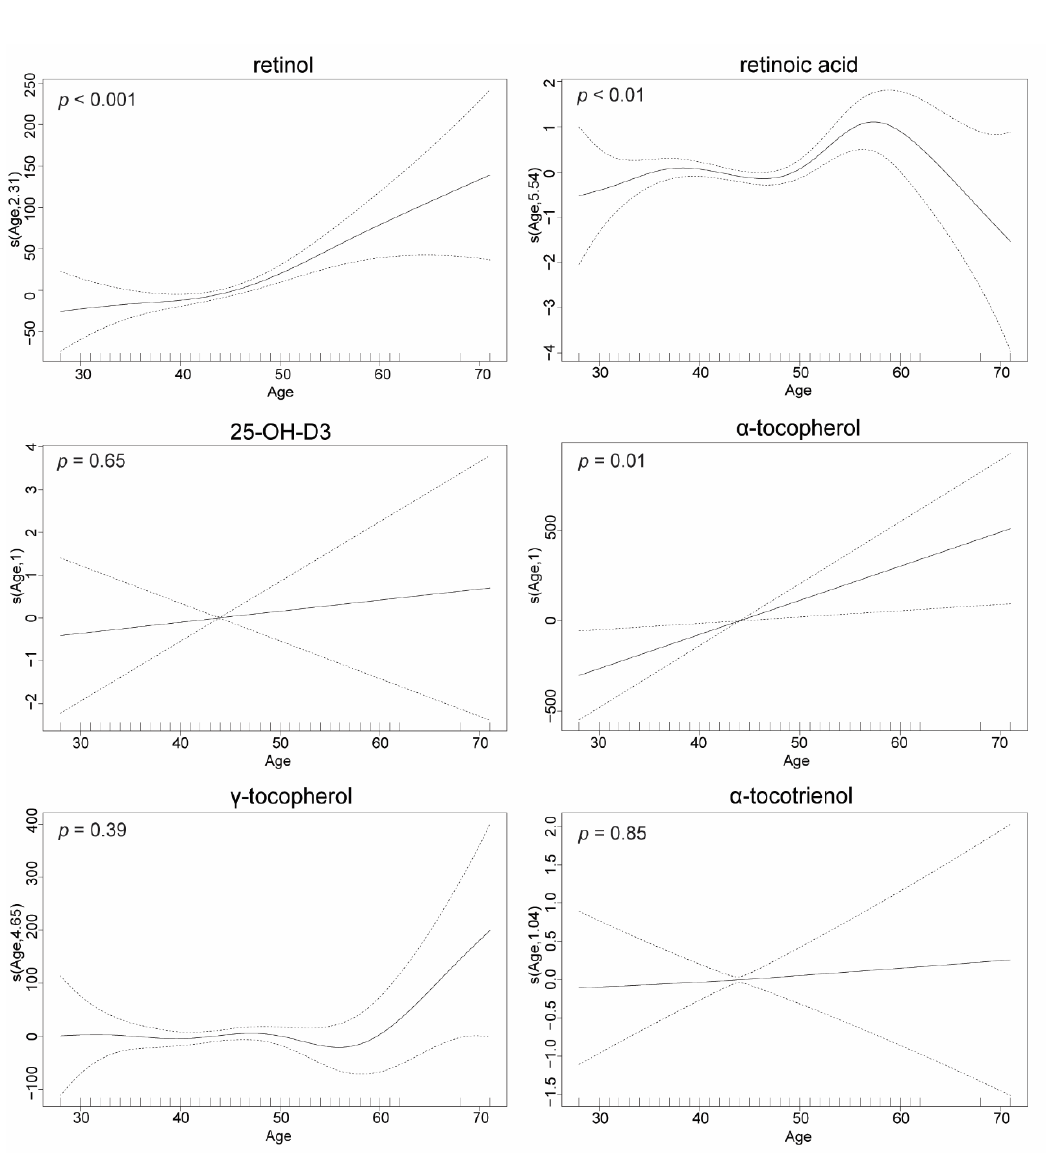
Figure 3. Generalized additive models of age effect on FSV concentrations. The number in s(Age, number) is the degree of freedom selected by the generalised cross-validation. When the number is one the procedure has selected a linear fit for the model. The dotted lines are estimate +/− 2 standard errors. The smooth functions are constrained to sum to zero over the observed covariate values; when a linear model is selected, this means that the function must be zero at the mean of the observed covariate values (0 uncertainty). The extreme ends of the curves are influenced by a small number of data points with unusual covariate values; this is reflected in the large window of uncertainty for these regions.